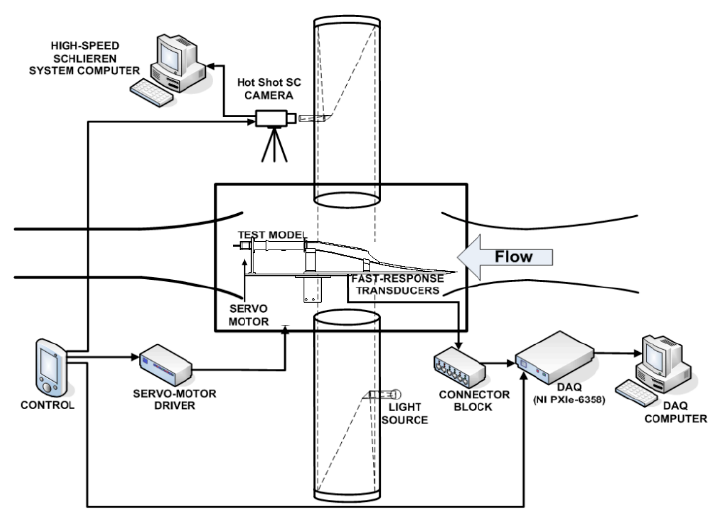
Figure 4. Hypersonic wind tunnel of Nanjing University of Aeronautics and Astronautics (NHW).